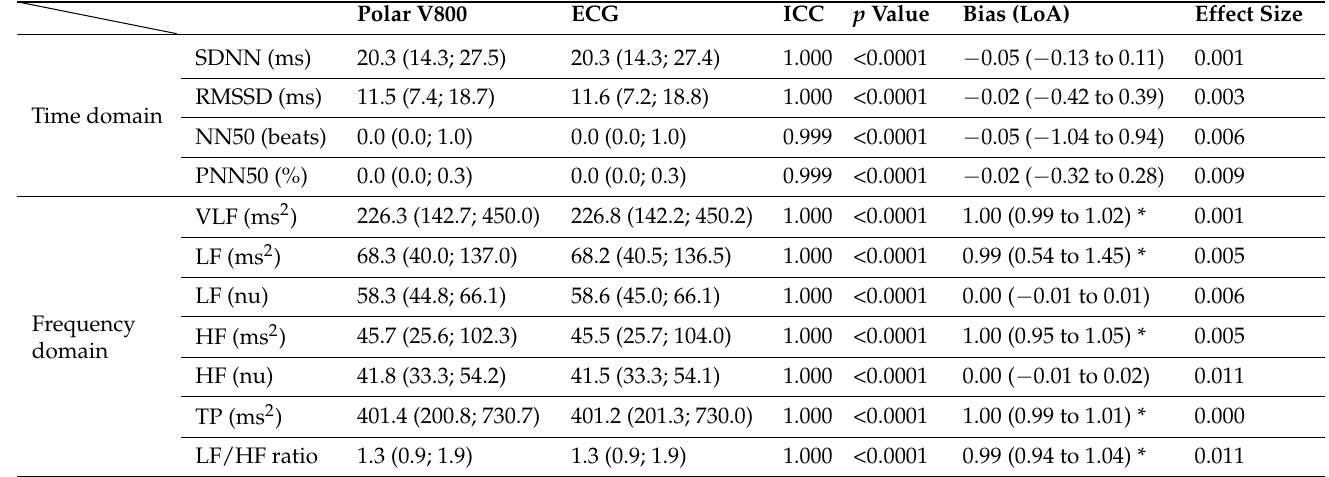
Table 8. HRV parameters for naming test at